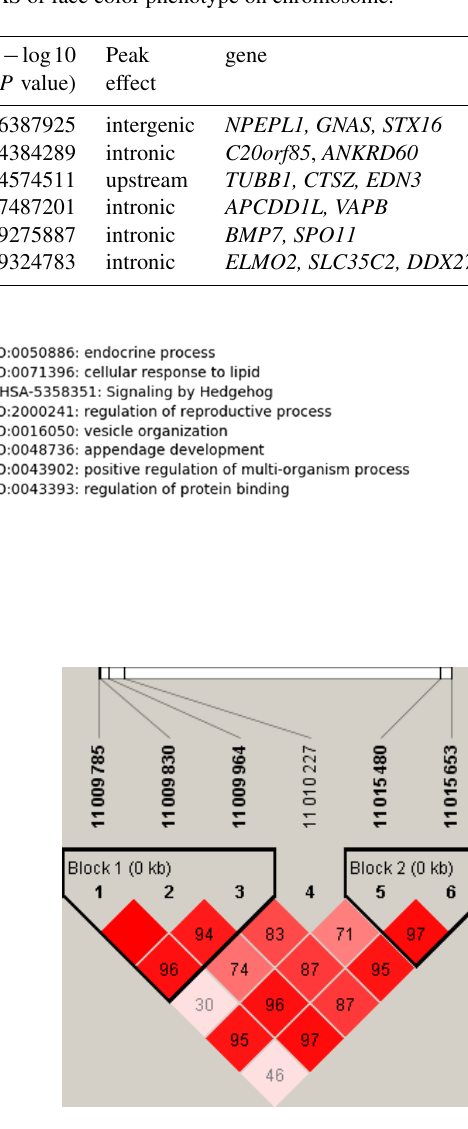
Figure 6. Linkage disequilibrium plot between six significant SNPs on EDN3